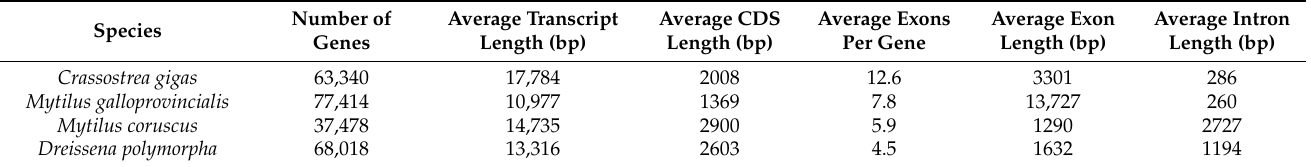
Table 5. Basic statistical results of gene structure prediction of relative